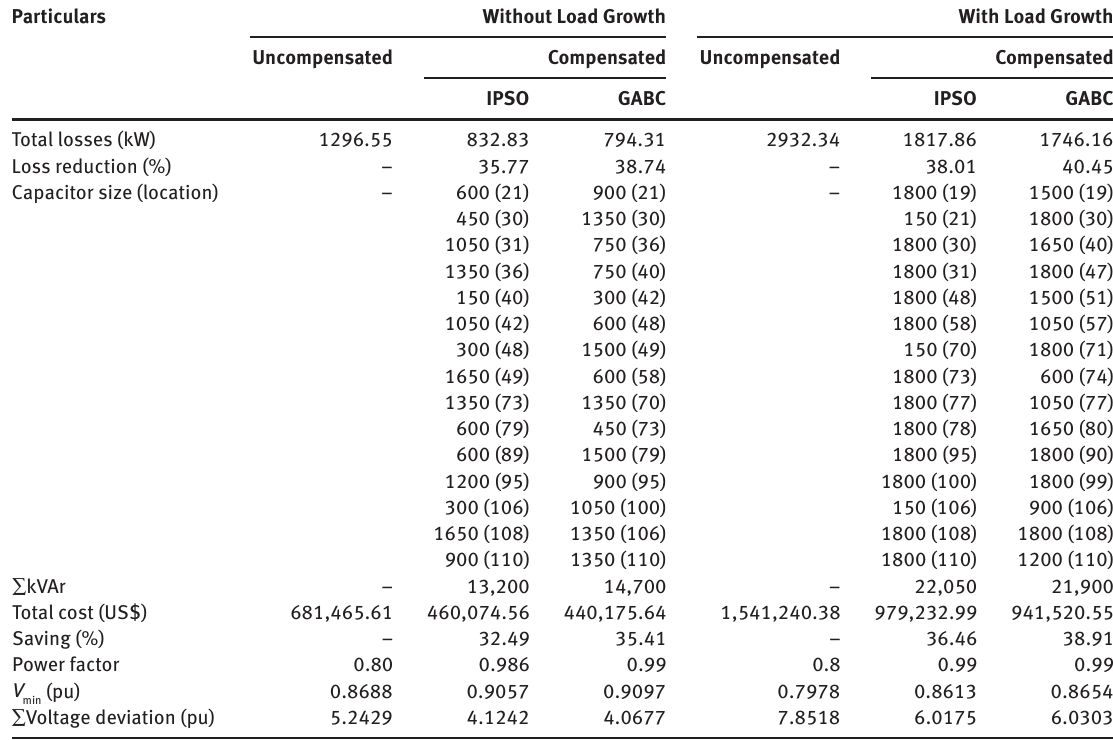
Table 12: Simulation Results of the 118-Bus Distribution Network after SC Placement Using the Proposed Approach.